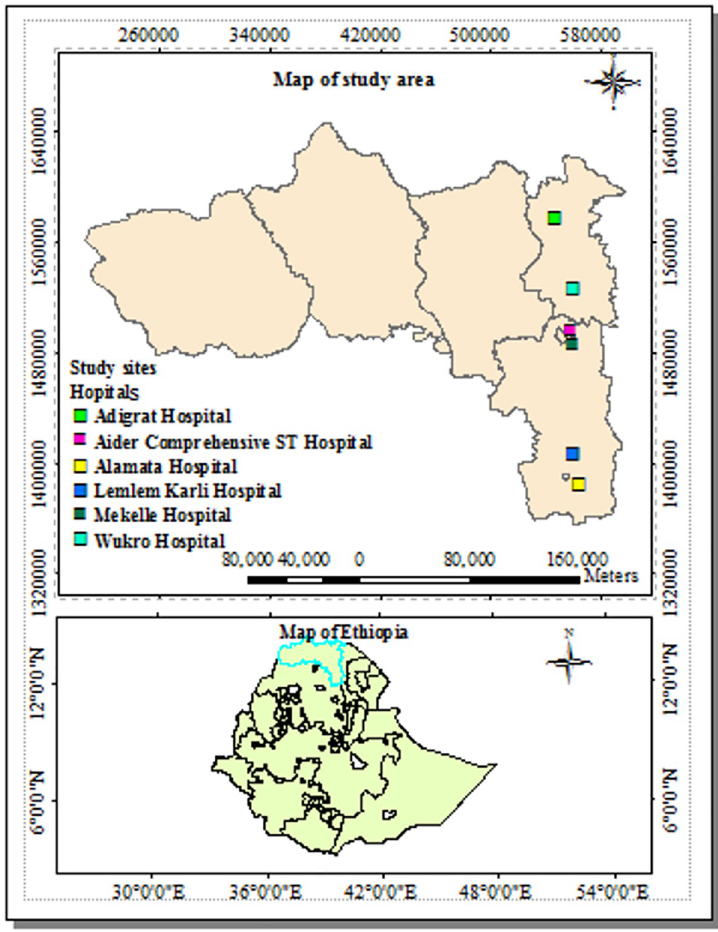
Fig 1. Map of the study